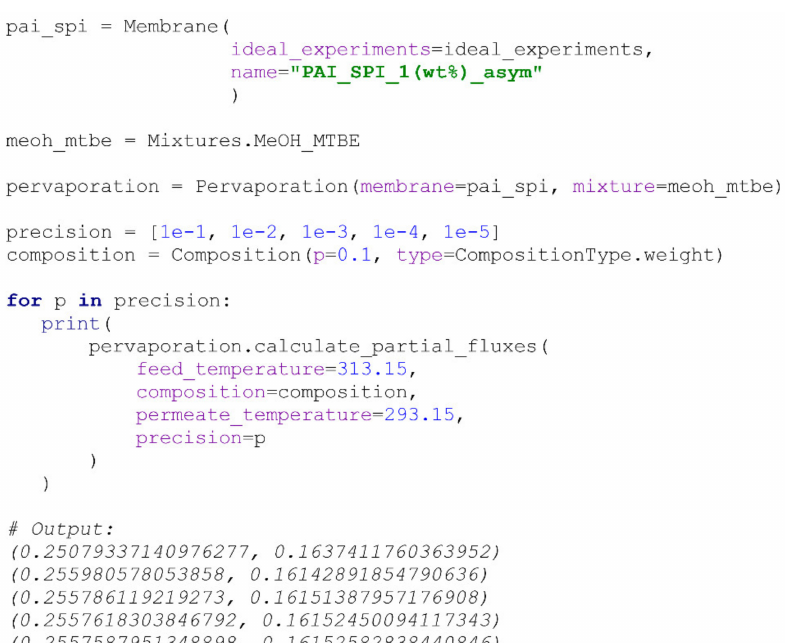
Scheme 10. Illustration of the influence of the precision value on the obtained flux values. Data for PAI-SPI (1 wt%) membrane’s performance in relation to the separation of methanol/MTBE mixtures were taken from